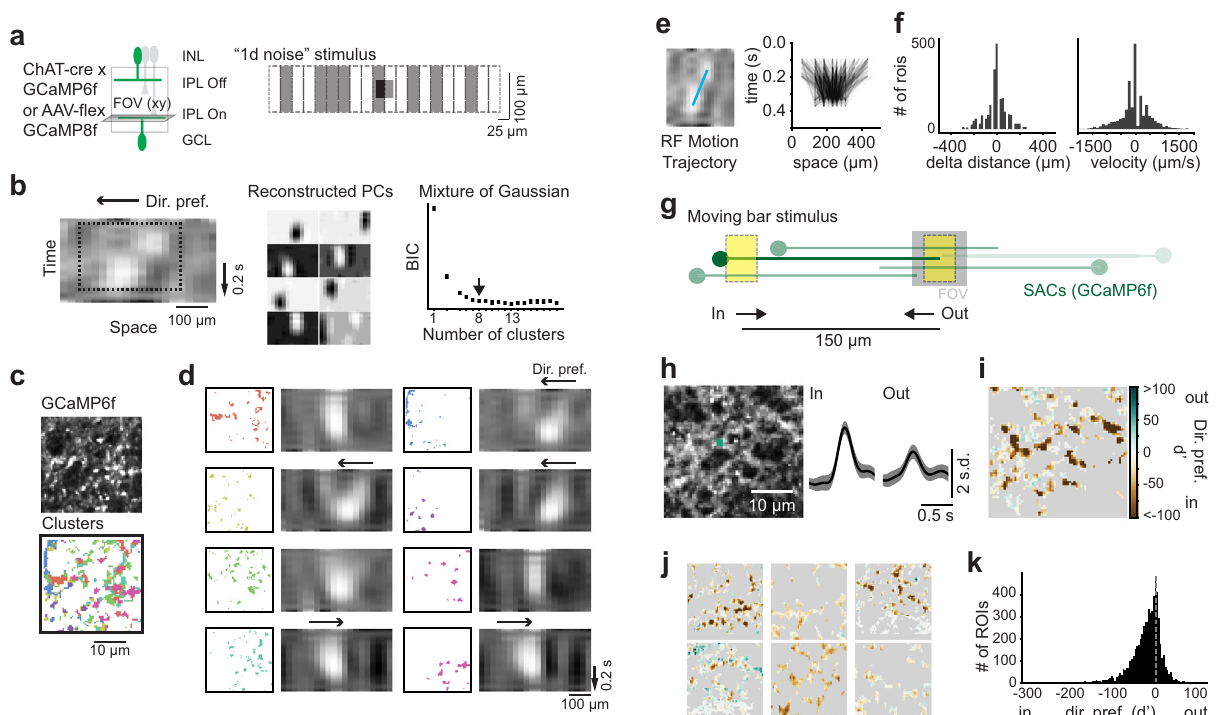
Fig.8|Starburstamacrinecellsrespondstronglytomotionrestrictedtoshort distances. a Left: for starburst amacrine cell (SAC) speci fi c labeling, fl ex-GCaMP6f and ChAT-cre mice were crossed or ChAT-cre mice were injected with AAV encoding fl ex-GCaMP8f. Data from both sensors are included. Right: “ 1D noise ” stimulus. b Clustering ROIs into groups based on their RFs. Left: example RF with leftward direction preference. Dotted line is cropped region used for clustering. Middle: Reconstructed components of the sparse PCA. Right: Plot of BIC for dif- ferent number of clusters using Mixture of Gaussian clustering. Arrow: chosen number of clusters (8). c Left: example scan fi eld (s.d. image) showing GCaMP6f expression in SACs. Right: ROIs color-coded by clusters determined in ( b ). d ROIs within each cluster with their average RFs. e Left: example ROI RF showing esti- mated motion trajectory (blue line). Right: motion trajectories for all ROIs color- coded by cluster ( n =2164 ROIs, 5 scan fi elds, 4 mice). f Left: histogram of the